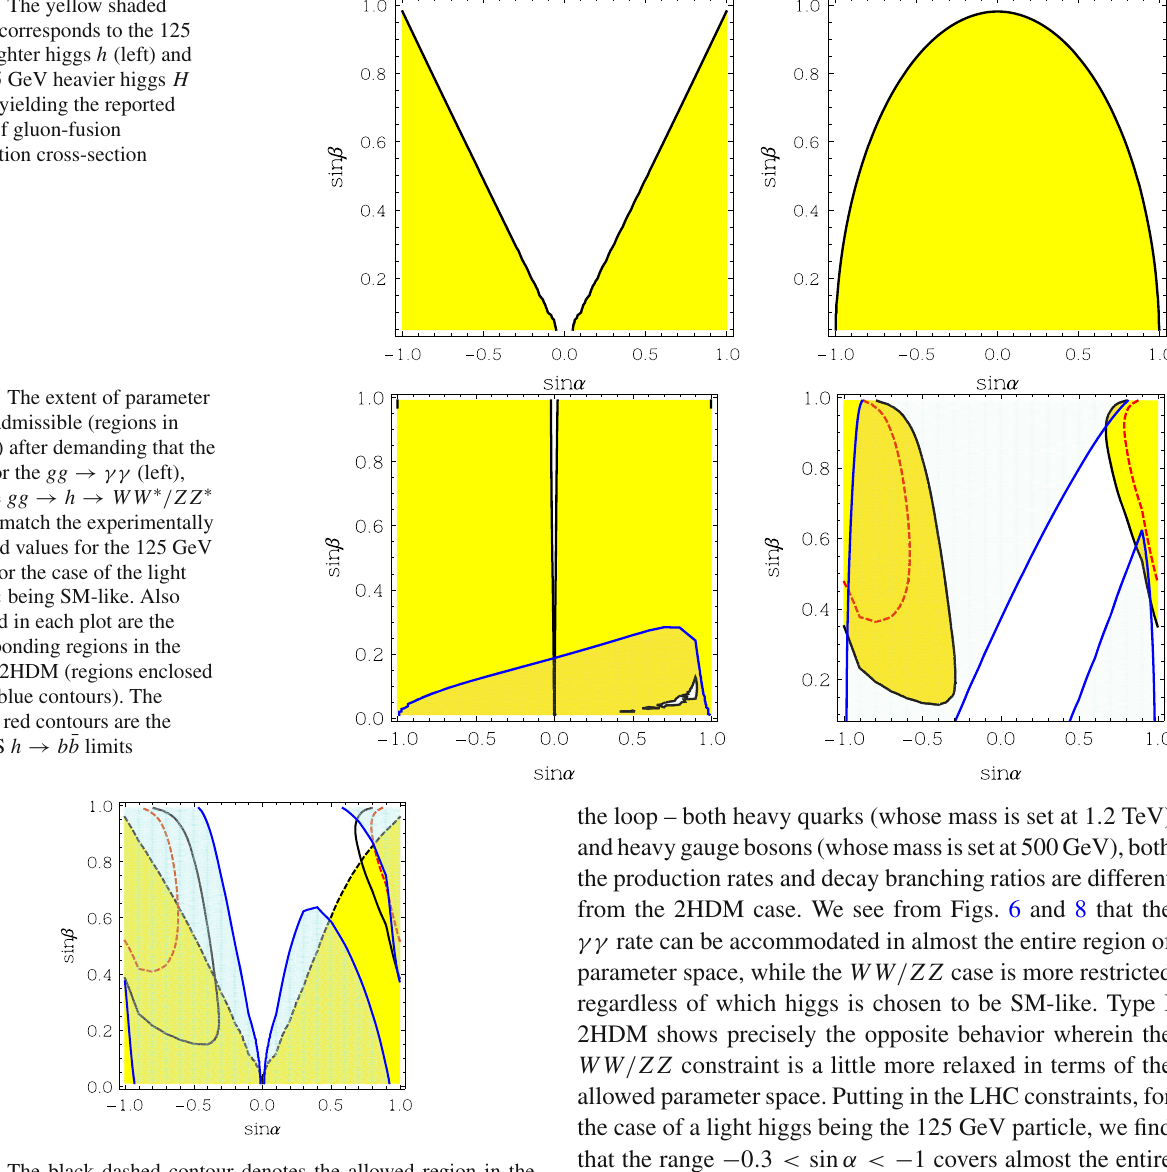
Fig. 7 The black dashed contour denotes the allowed region in the parameter space satisfying the h → τ + τ − data. The intersection region betweentheblack,reddashed,andblackdashedlinessatisfiestheHiggs measurement data from the ATLAS and CMS